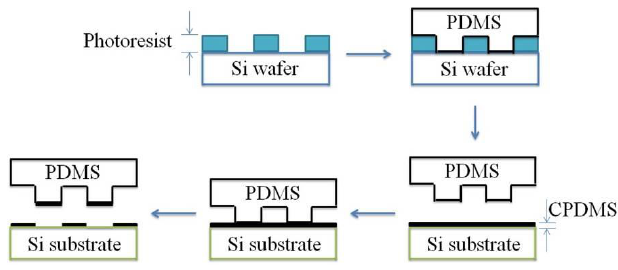
Figure 4. Micro-molding and stamping (micropatterning) fabrication process.